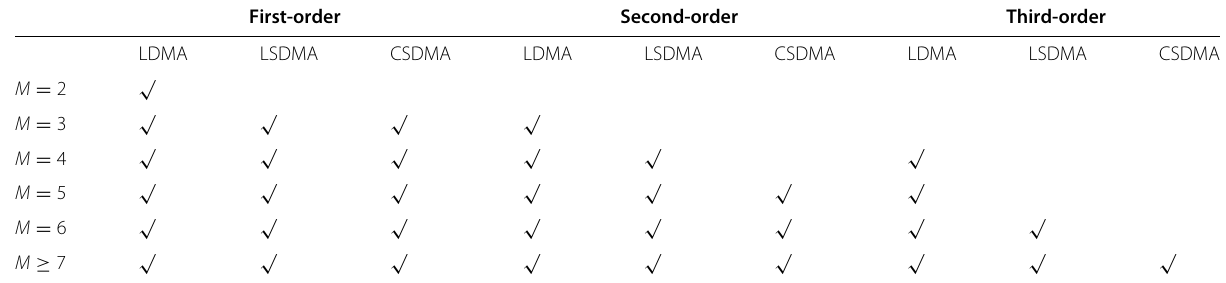
√ ” represents feasible and